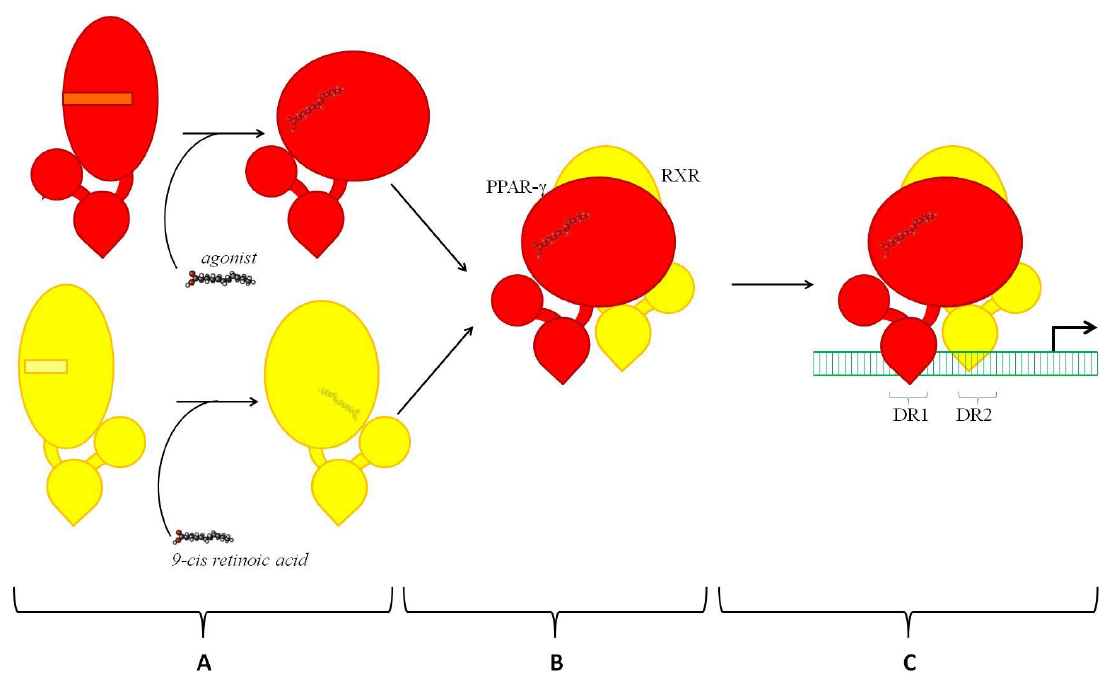
Figure 2. Transactivation of PPAR- γ . A—Interactions of agonist with PPAR- γ (shown in red) and 9-cis retinoic acid with RXR (shown in yellow). The activation of PPAR- γ and RXR by their ligands causes conformational changes. These changes cause dissociation of protein repressors and recruitment of activators (not shown). B—Heterodimerization of PPAR- γ and RXR. C—Binding of the heterodimer RXR-PPAR- γ to PPRE on the DNA. DR1 and DR2 are two halves of PPRE separated by a single nucleotide